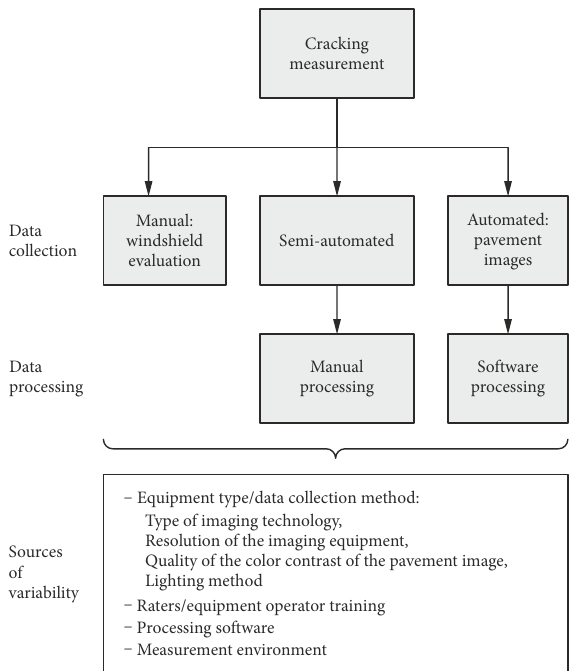
Figure 1. Sources of variability in pavement cracking data collection and processing (Flintsch, McGhee 2009; McNeil, Humplick